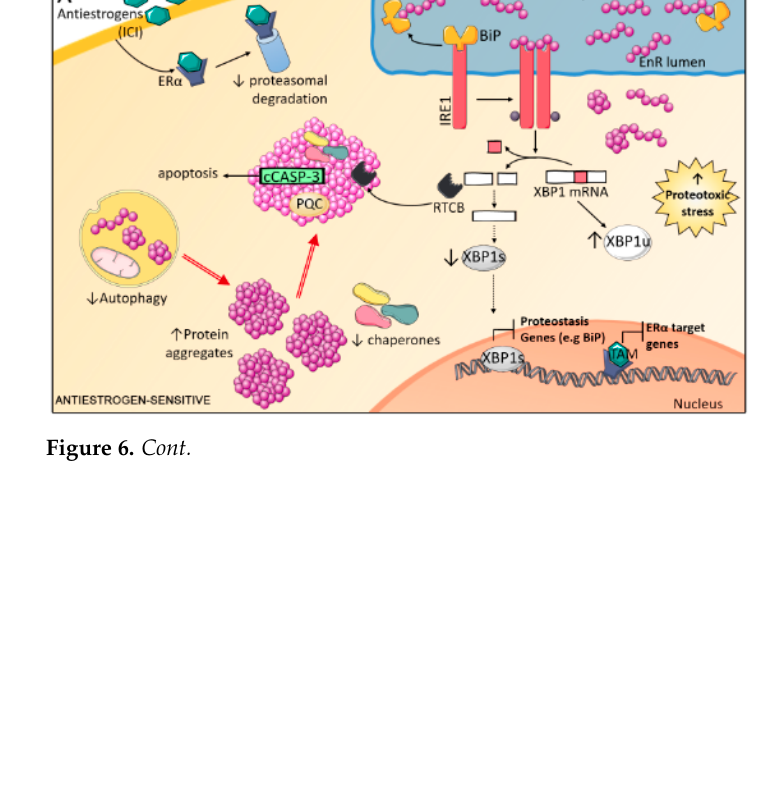
Figure 6. Schematic representation of the findings presented in this work in the context of previously described mechanisms guiding endocrine resistance. ( A ) In antiestrogen-sensitive cells, treatment with antiestrogens induces ER α proteasomal degradation (ICI) or inhibits the transcription of ER α target genes (TAM); consequently, proliferation and survival signaling is halted. Additionally, an- tiestrogen therapy increases oxidative and metabolic stress, which hinders correct protein folding to increase their aggregation. The results presented herein show that the PQC network (autophagy, UPR and proteasome) may be rapidly saturated leading to aggresome accumulation. Aggresomes contain essential proteins needed to overcome proteotoxic stress (i.e., RTCB, chaperones and PQC